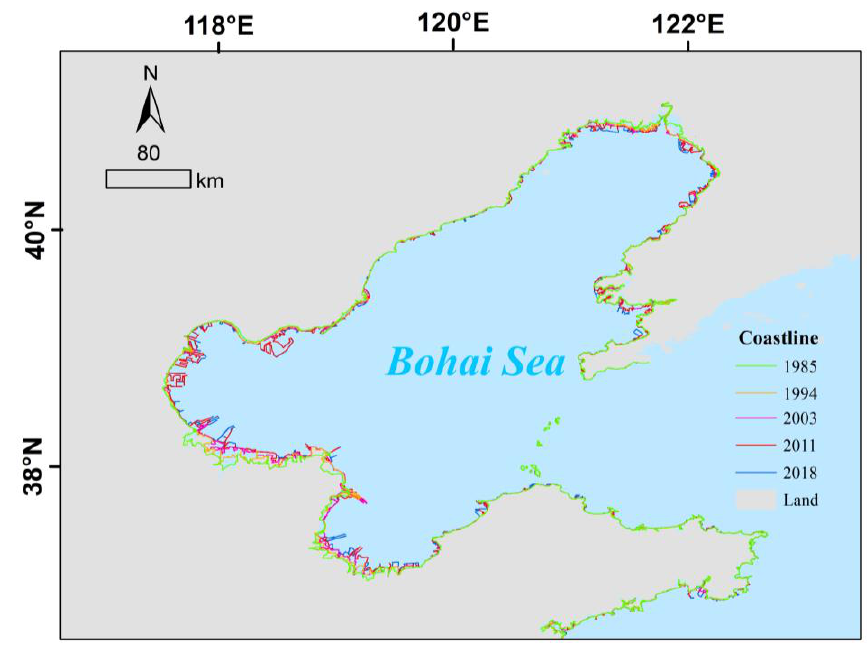
Figure 6. The coastline changes in the BHS.